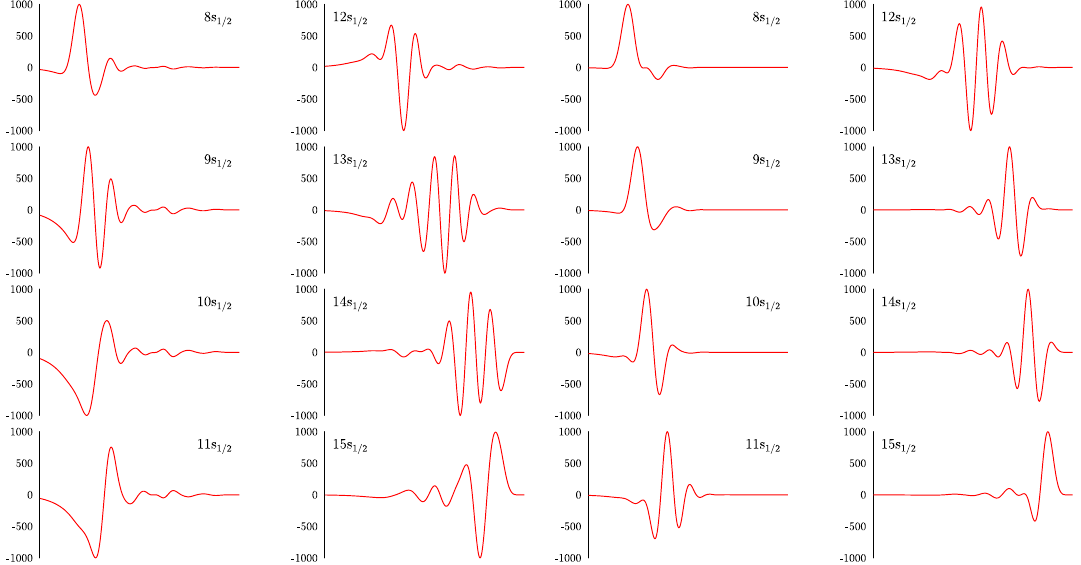
Figure 2. Upper components of the virtual orbitals for partial wave s 1/2 of Au atom generated from 15 orthogonal B-splines. Left ( right ) panel corresponds to the set Π + ( Π − ). See Equation (7) and the text for